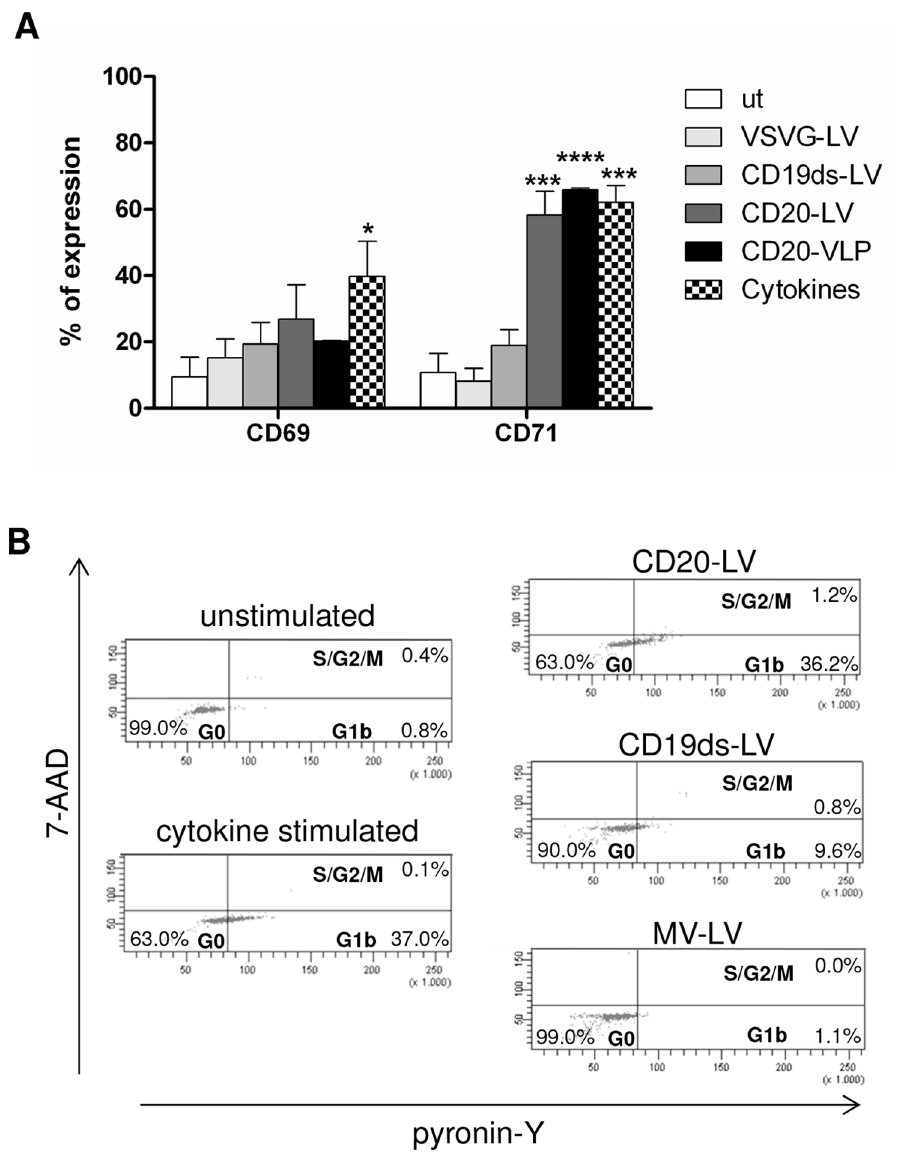
Figure 4. CD20-LV and CD19ds-LV induce minimal activation of resting primary human B lymphocytes. ( A ) Freshly isolated primary human B lymphocytes were left untransduced or were incubated with CD20-LV, CD19ds-LV or VSVG-LV at an MOI of 1.5–2 or with CD20-VLP at the same HIV p24 value as CD20-LV. As positive control, B lymphocytes were activated with a cytokine cocktail consisting of 50 ng/ml IL-2, 300 ng/ml CD40Ligand, 10 ng/ml IL-4 and 10 ng/ml IL-10. Forty-eight hours later, the cell surface expression of the activation markers CD69 and CD71 was determined by FACS analysis using appropriate antibodies. Mean values of CD69 + and CD71 + cells, respectively, of four different donors and SEM are shown. *, ***, and ****indicate P , 0.05, P , 0.001 and P , 0.0001 versus untransduced cells, respectively. Data were analyzed by two-way ANOVA. ( B ) Freshly isolated primary human B lymphocytes were transduced by CD20-LV (MOI 3), CD19ds-LV (MOI 3) or MV-LV (MOI 5) vectors or remained untransduced. As positive control, B lymphocytes were activated with the same cytokine cocktail as described for (A). Forty-eight hours later, cell cycle progression was monitored by simultaneously visualizing the RNA (pyronin-Y) and DNA (7-AAD) content of the B lymphocytes by FACS analysis. The percentages of cells in G0, G1b or S/G2/M phase of the cell cycle are indicated. One representative experiment out of four